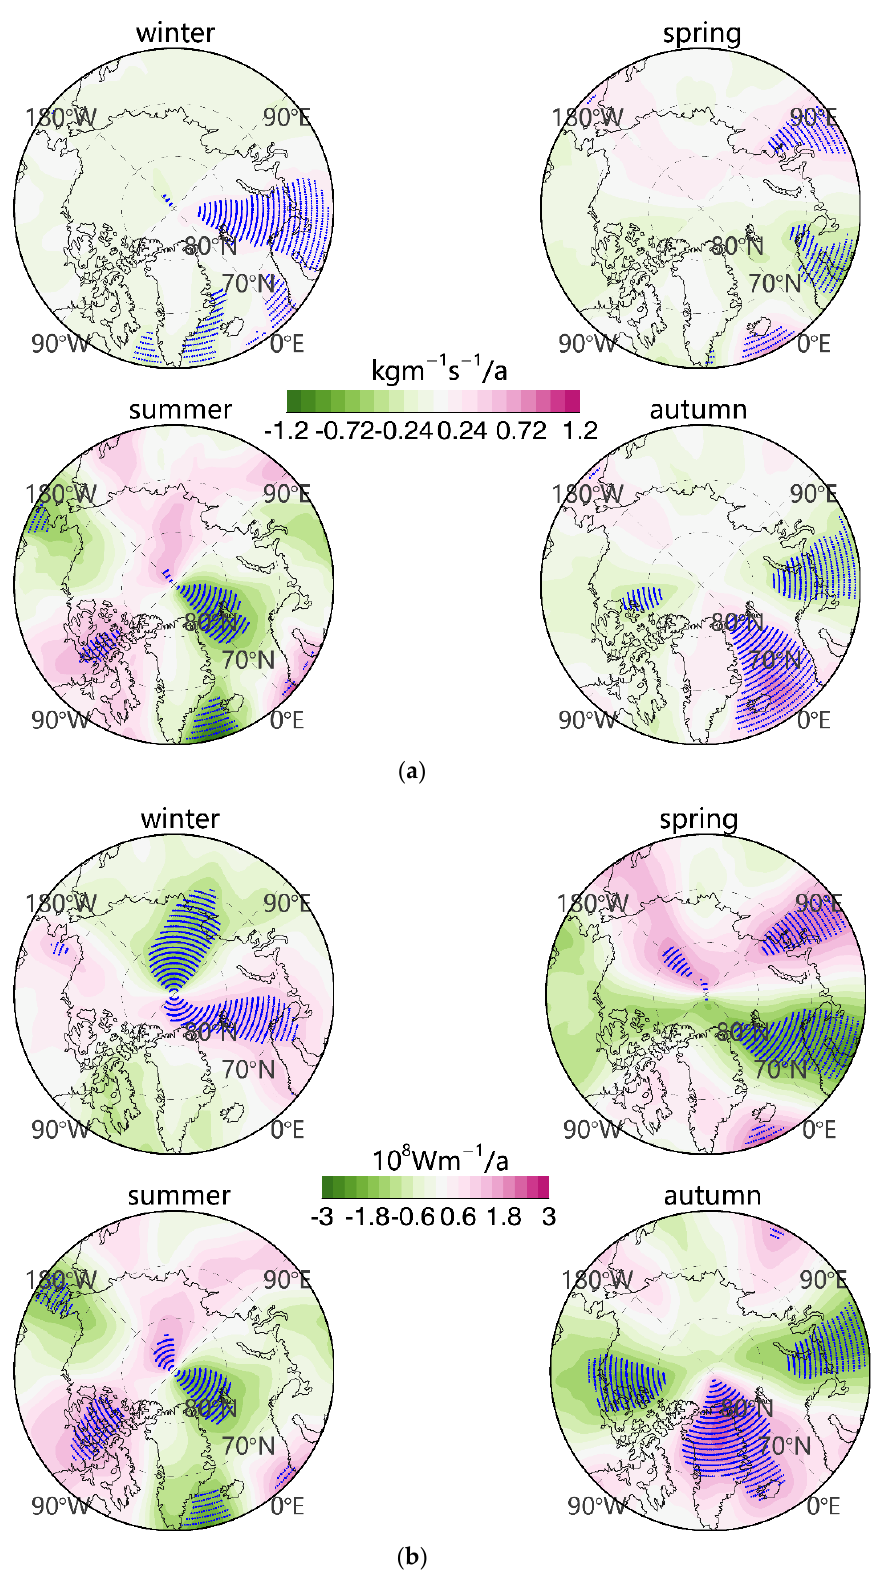
Figure 5. Spatial distribution of the trends of ( a ) moisture flux and ( b ) energy flux across 70 °N in the ERA5 product over the period 1979 – 2020. The seasons are divided into spring (March to May), summer (June to August), autumn (September to November), and winter (December to February). The stippled grids denote those with trends significant at the 95% confidence level.